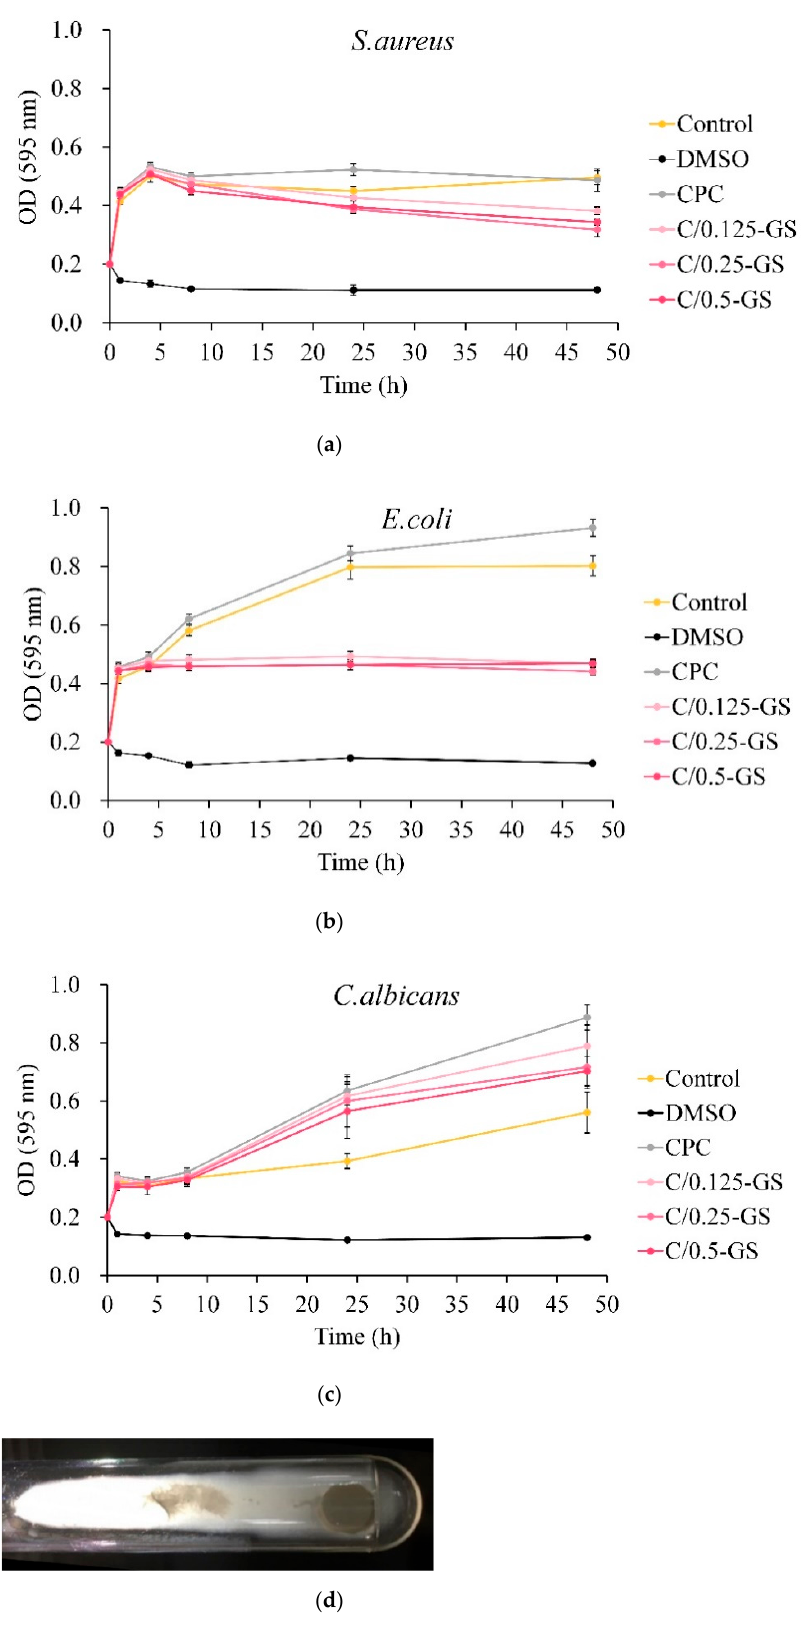
Figure 8. Quantitative analysis of bacterial activity inhibition by gentamicin release from CPC/hydrogel composites against ( a ) S. aureus , ( b ) E. coli , and ( c ) C. albicans ( n = 3); ( d ) optical image of C. albicans mycelium after culture, which shows that hyphae affect the OD value reading.